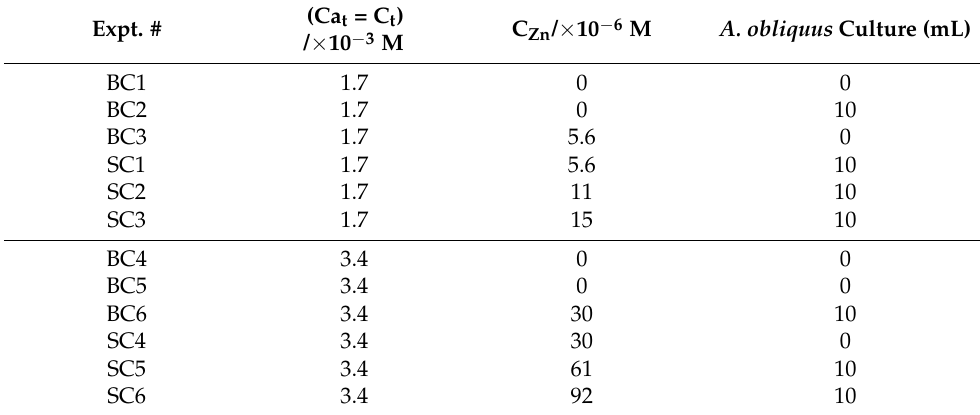
Table 2. Experimental conditions for calcium carbonate precipitation in the presence of zinc under illumination in the absence and presence of A. obliquus culture and nutrient medium; Expt. #, total calcium, Ca t = total carbonate, C t , concentration, zinc (total) concentration, C Zn , and volume of A. obliquus culture; 25 ◦ C, pH initial 8.50, 0.15 M of NaCl. (Ca t = C t ) C Zn / × 10 − 6 M A. obliquus Culture (mL) Expt. # / × 10 − 3 M BC1 1.7 0